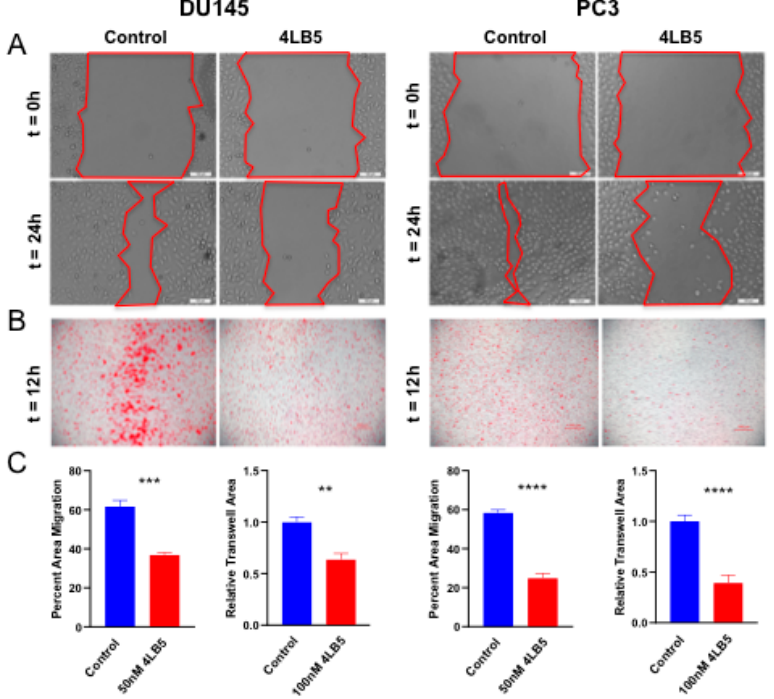
Figure 4. 4LB5 Impairs PCa Cell Migration ( A ) Wound healing assays performed with DU145 and PC3 cells after 48h of pretreatment with 50 nM 4LB5 or control solution. Representative photos were taken at t = 0h and t = 24h. ( B ) Trans-well migration experiments performed with DU145 and PC3 cells after 24h pretreatment with 100 nM 4LB5 or control solution and 12h migration time. Migrated cells were stained with crystal violet and photographed with phase contrast microscopy. ( C ) Images of control- and 4LB5-treated migrated cells for experiments shown in A and B were processed and analyzed with ImageJ software in parallel. Quantification of images from five independent wound healing experiments performed in technical triplicate is reported. Trans-well migration data represents average of two independent experiments performed in biological triplicate and was generated by calculating percent area of migrated cells. ** p < 0.01, *** p < 0.001, **** p < 0.0001.